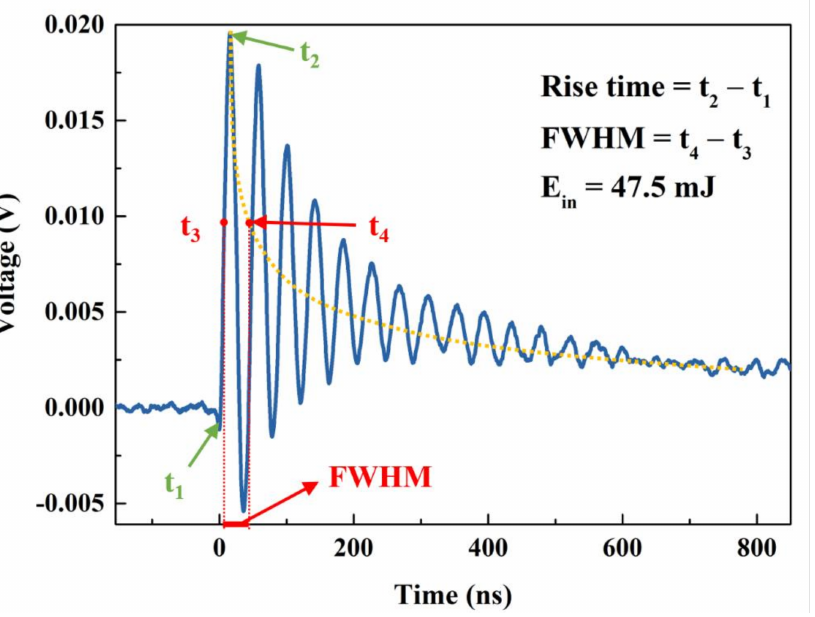
Figure 5. Response of pyrite under the irradiation of 248 nm laser with E in = 47.5 mJ. Pyrite has an appropriate energy bandgap of ~0.95 eV, causing it to have excellent electron mobility and environmental compatibility [28]. When the sample receive a pulsed laser, photoexcited carriers was detected by the silver electrodes. As shown in Figure 6a, the LIV signals strongly depended on the laser fluence, with V p monotonically increasing with energy density from 2.3 to 3.96 mJ /mm 2 . Time-dependent LIV under selected irradiation areas from 1 to 16 mm 2 is shown in Figure 6b. V p was significantly improved from 0.77 to 10 mV when the E in increased, owing to the change to a laser irradiation area. Responsivity (R) is a critical factor for evaluating a detector which is defined as the ratio of (V p − V dark ) and the incident optical energy intensity E in , where V dark is the noise voltage in the dark. The responsivity is expressed by R = (V p − V dark )/E in . The maximum R is about 0.52 V/mJ in our case. The specific detectivity (D*) is a key figure-of-merit for describing the smallest detectable light density by a photodetector. This can be calculated according to D* = R*A 1/2 /(2eV dark /R 0 ) 1/2 , where R is the calculated responsivity, A is the active area (in mm 2 ), e is the electron charge and R 0 is 1 M Ω . The minimum value of D* calculated for the measurement system fabricated in this study is found to be ~1.4 × 10 13 Jones. The results suggested the pyrite device, which shows that the pyrite device is highly responsive and very sensitive to UV laser